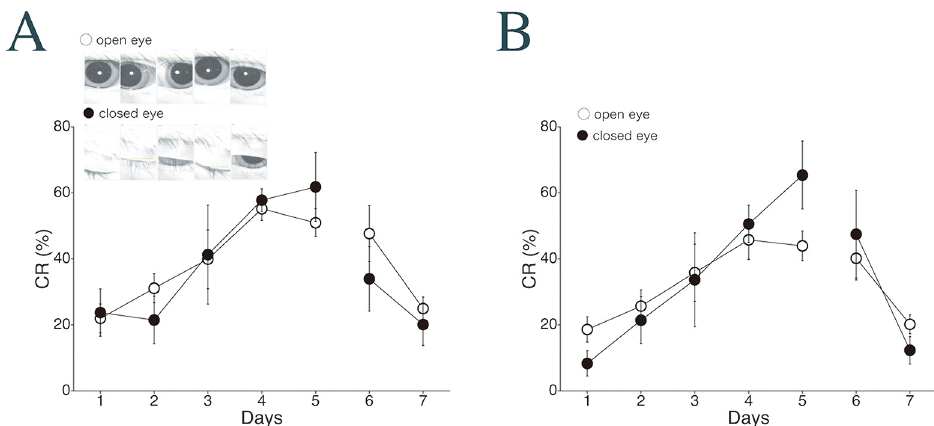
Fig 9. Changes in CR expression over the experiment in cases of open vs. closed eyes. The CR incidence (CR%) averaged over all monkeys ( n = 5) in cases of eyes open and closed just before CS onset are compared between the EMG channel (A) and the Intelligent Vision Sensor channel (B). Insets in (A): representative images of an “ open eye ” and a “ closed eye ” as judged by the video-tracking system. Data are presented as mean ±